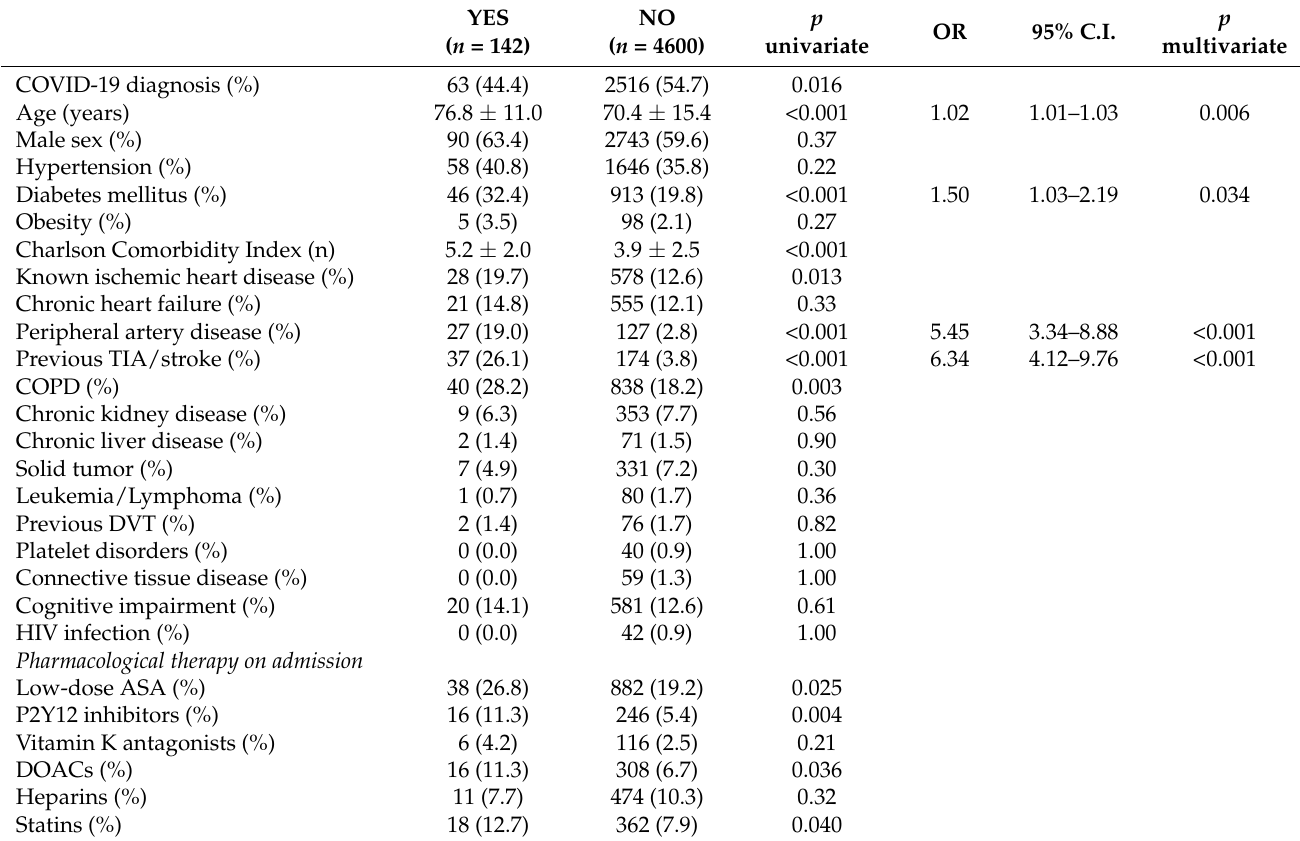
Table 5. Cumulative arterial thrombosis in the whole